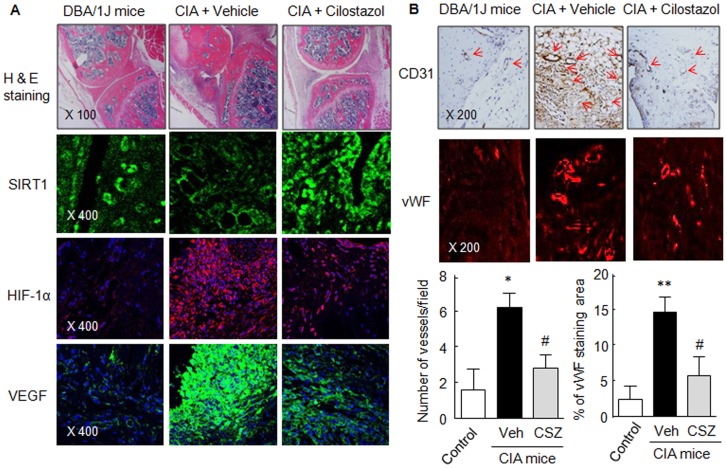
Immunohistochemistry (H & E and CD31) and immunofluorescence (SIRT1, HIF-1α and VEGF) assay.(A) Photographs showing SIRT1(+)-, HIF-1α (+)- and VEGF (+)-spots in joint sections of vehicle control and cilostazol (CSZ)-treated CIA mice. (B) Tibiotarsal joint tissue sections were stained with anti-CD31 antibody, and rabbit anti-human vWF (a marker of endothelial cells). Numbers of blood vessels/field and percentages of vWF stained area were analyzed in joint sections of CIA mice. Results are the means ±SEM of 4 experiments. *P<0.05, **P<0.01 vs. control; #
P<0.05 vs. vehicle (Veh)-treated CIA mice. The pictures shown are representative of 4 experiments that produced similar results.